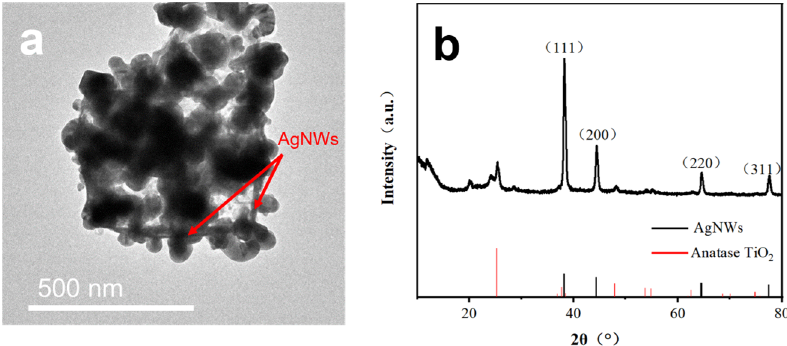
Figure 4. SiNPs@TiO 2 /AgNWs ( a ) TEM image, and ( b ) XRD spectrum.